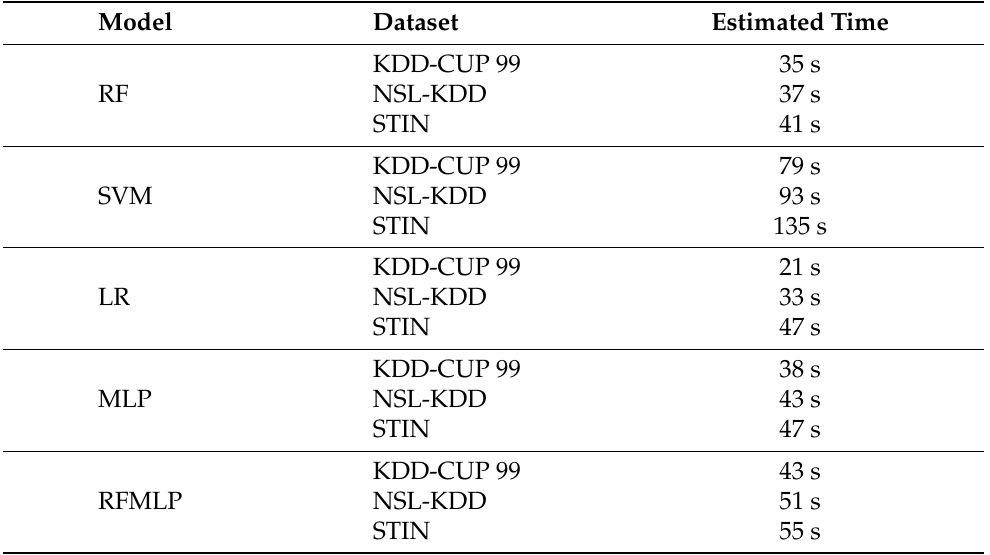
Table 10. Estimated execution time of all classifiers on all three